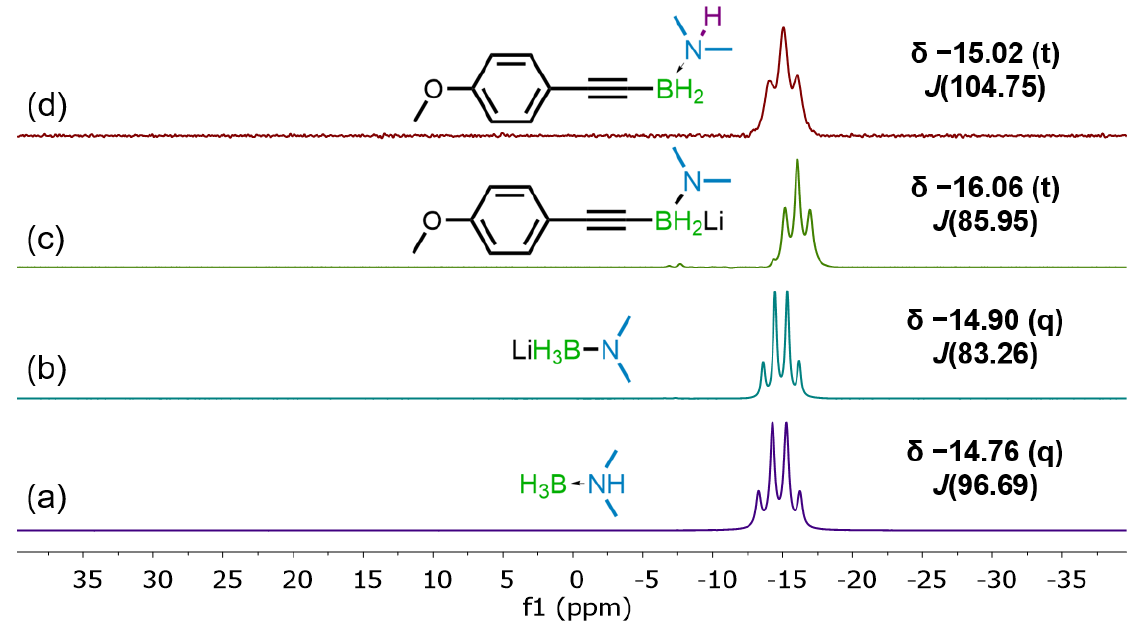
Figure 1. 11 B NMR peaks observed during reaction monitoring experiment; ( a ) dimethylamine- borane starting material, ( b ) lithium dimethylaminoborohydride after n -BuLi addition, ( c ) lithium dimethylaminoalkynylborohydride following dehydroborylation, ( d ) final product obtained after water quench.